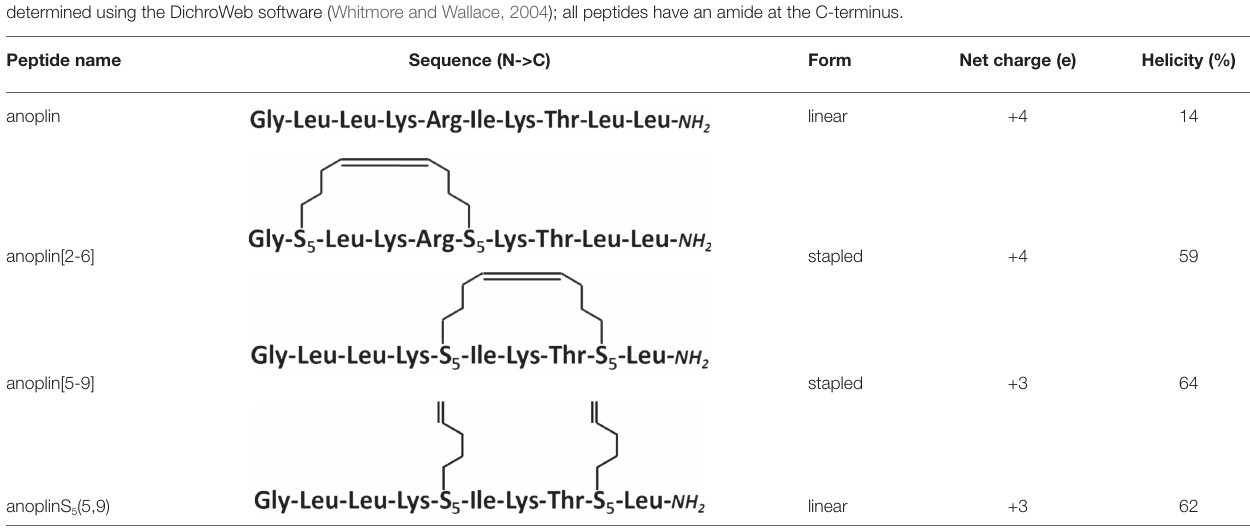
into the anoplin sequence induced the α -helical structure ( Figure 1C red and green lines). The percentage of the helix in stapled anoplin[2-6] increased to 59% and anoplin[5-9] to 64% as compared to the unmodified peptide ( Table 1 ). A surprisingly clear representative spectrum of an α -helix was obtained for anoplinS 5 (5,9) in the phosphate buffer ( Figure 1C , blue line).